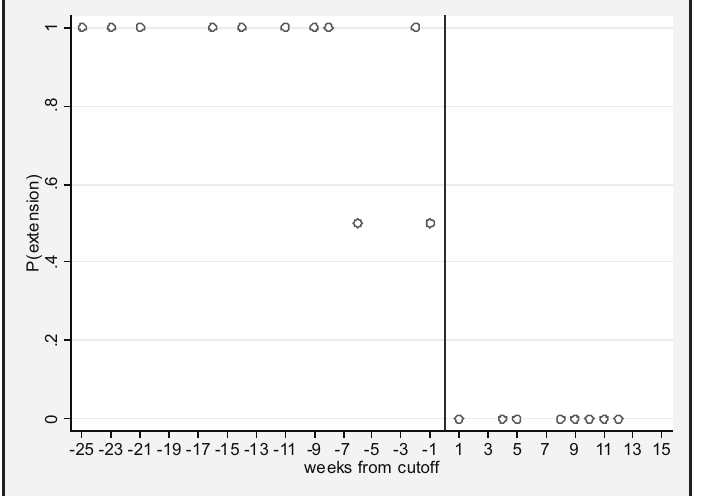
The probability that a collective agreement is